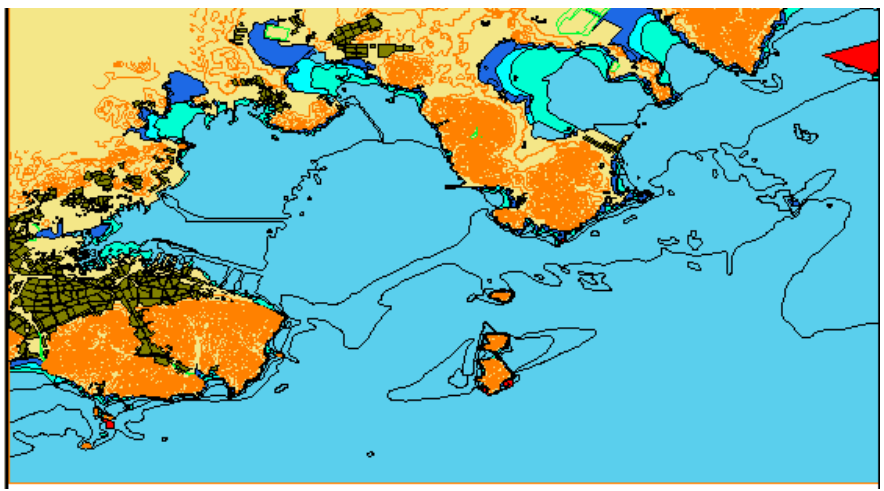
Figure 6. Dalian sea area electronic nautical chart.